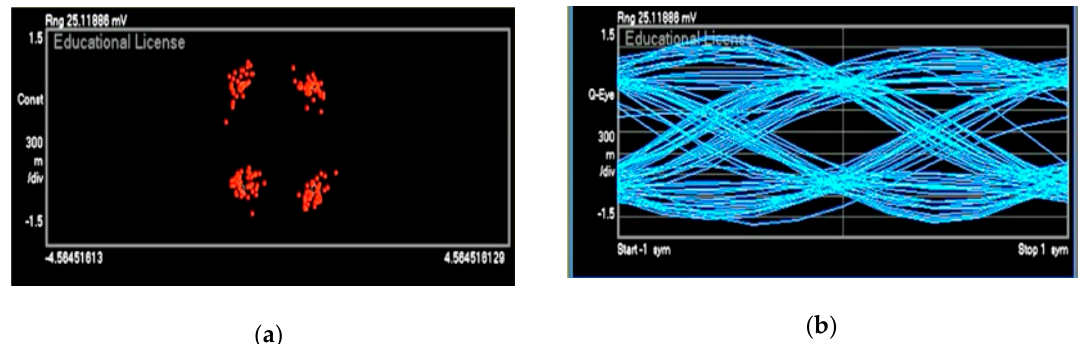
is broad and clear without a symbol crossing. By further increasing the bit energy of the transmitted